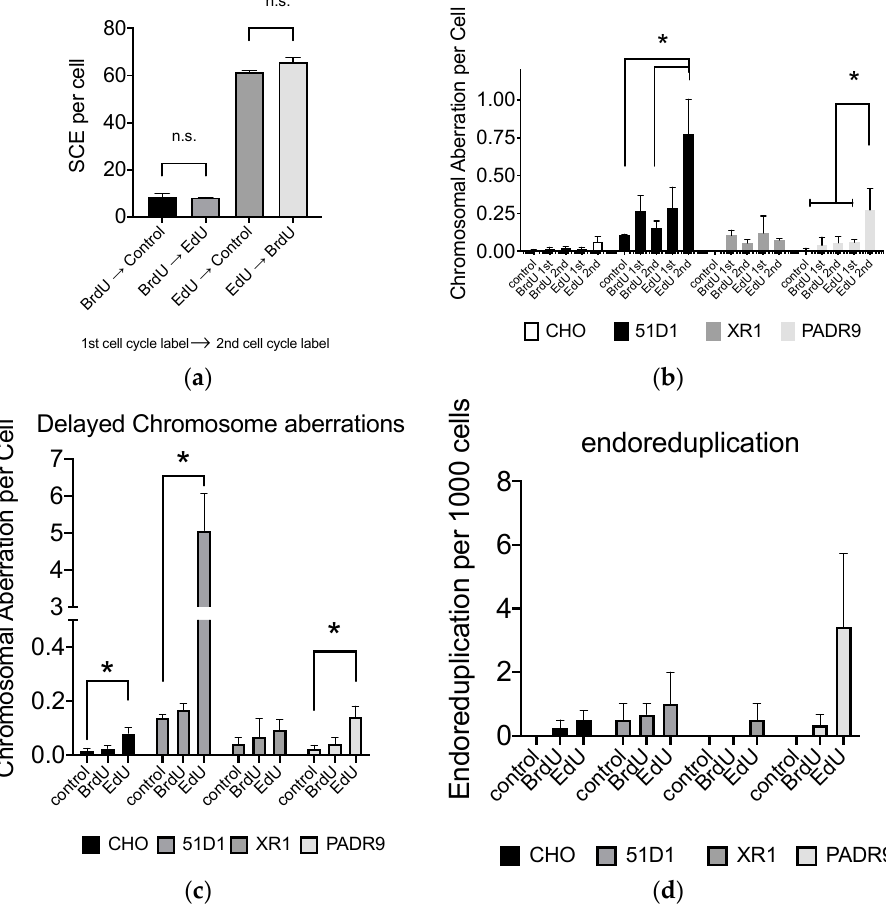
Figure 7. Delayed EdU effect for genomic damages. ( a ) The first cycle with BrdU or EdU determines SCE formation but not the second cycle. BrdU or EdU (50 μ M) was incorporated; ( b ) EdU affects second post-treated metaphase and induces chromosomal aberrations. Chromosomal aberrations were compared with control, after one complete cycle of 10 μ M BrdU or EdU treatment, and after two complete cycles of 10 μ M BrdU or EdU treatment; ( c ) delayed chromosome aberration formation with DNA repair-deficient cells treated with 10 μ M BrdU or EdU; ( d ) endoreduplication formation after 10 μ M BrdU or EdU treatment. Error bars represent the standard error of the mean of three independent experiments. One-way ANOVA, Dunnett’s Multiple Comparison Test was performed to provide p -values. * indicates statistically significant differences. n.s. stands for not significant ( p > 0.05).